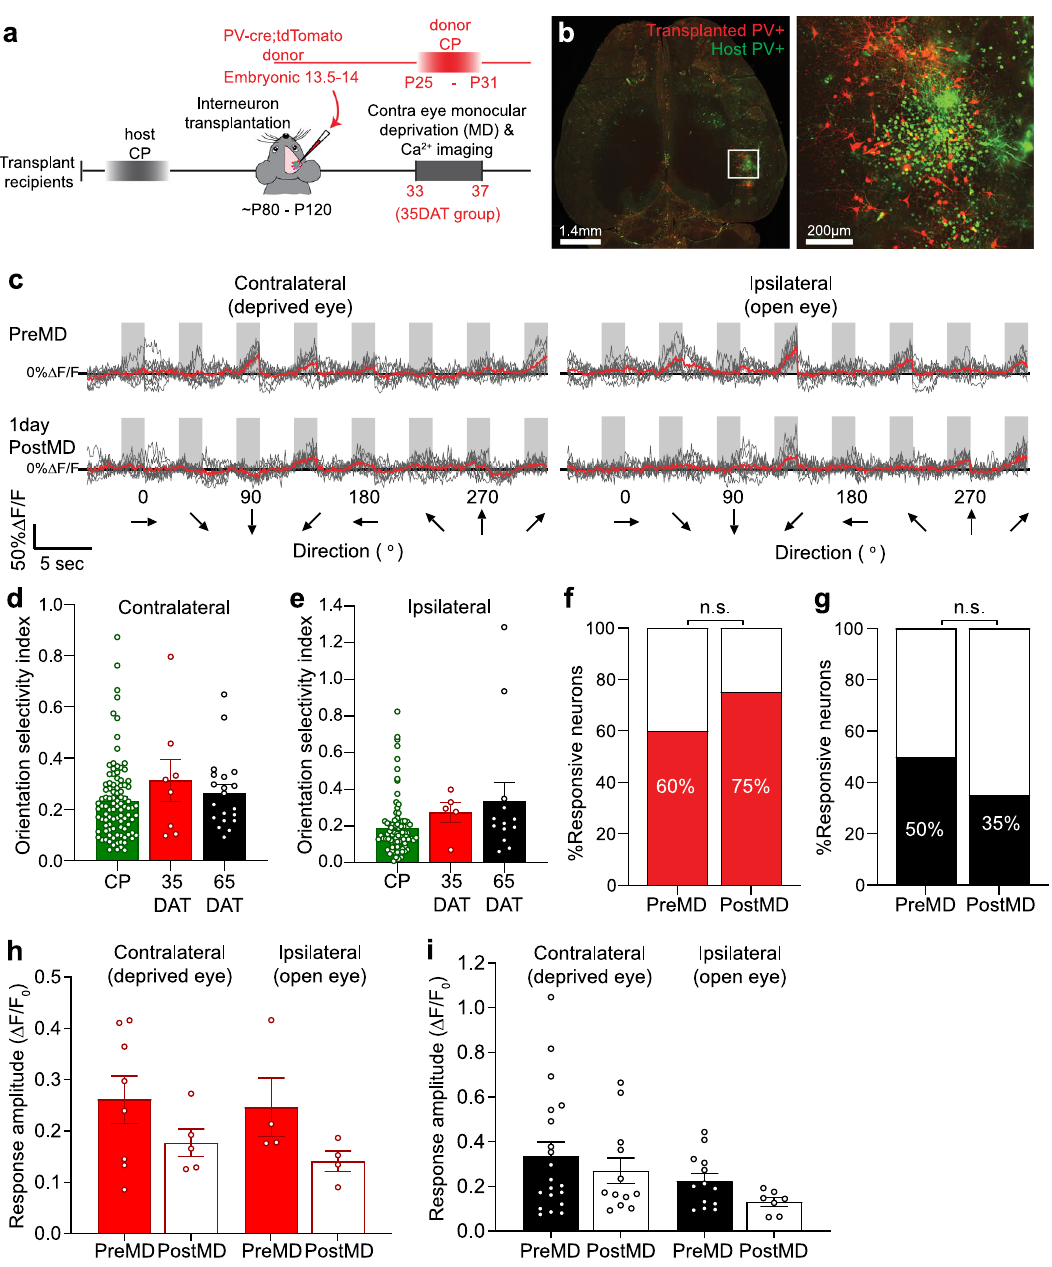
Fig. 3 Transplanted PV interneurons are not sensitive to MD. a Experimental timeline. The calcium imaging of transplanted PV interneurons was performed at 33 – 35 days after transplant (35DAT) or 65 – 70DAT. b Left: whole brain image of transplant recipient cleared using iDISCO + method, scale bar = 1.4mm. Right: a magni fi ed view of the outlined region in the left panel. Transplanted PV interneurons are in red, and AAV1-GCaMP6s-labeled host PV interneurons are in green and transplanted PV interneurons are in yellow, scale bar = 200 µ m. This experiment was performed in one transplant recipient. c Visually evoked responses of an example transplanted PV interneuron. d , e There was no difference in the orientation selectivity index between critical period (CP, green) PV interneurons, and 35DAT (red) and 65DAT (black) transplanted PV interneurons. d Orientation selectivity index for the contralateral responses (CP: n = 98 cells from 3 mice; 35DAT: n = 8 cells from 6 mice; 65DAT: n = 20 cells from 5 mice; p = 0.339, Kruskal – Wallis ANOVA test). e Orientation selectivity index for the ipsilateral responses (CP: n = 84 cells from 3 mice; 35DAT: n = 5 cells from 5 mice; 65DAT: n = 13 cells from 5 mice; CP vs. 35DAT, p = 0.144; 65DAT vs. 35DAT, p = 0.999 Kruskal – Wallis ANOVA with Dunn ’ s multiple comparison test). f Responsiveness of transplanted PV interneurons at 35DAT remained unchanged after 1D MD (PreMD: n = 15 cells from 6 mice; PostMD: n = 8 cells from 3 mice, p = 0.657, Fisher ’ s exact test). g The percentage of responsive transplanted PV interneurons also remained unchanged after MD for the 65DAT group (PreMD: n = 50 cells from 5 mice; PostMD: n = 37 cells, p = 0.194, Fisher ’ s exact test). h The response amplitude of transplanted PV interneurons did not change after 1D MD for either the contralateral or ipsilateral eye (Contra PreMD: n = 8 cells from 6 mice, solid red; PostMD: n = 5 cells from 4 mice, open red; p = 0.284, Mann – Whitney U -test, two-tailed; Ipsi PreMD and PostMD: n = 4 cells from 4 mice; p = 0.114, Mann – Whitney U -test, two-tailed). i MD also did not signi fi cantly alter the response amplitude of transplanted PV interneurons at 65DAT through the contralateral eye (PreMD: n = 20 cells from 5 mice, solid black; PostMD: n = 12 cells from 5 mice, open black; p = 0.604, Mann – Whitney test, two-tailed) or ipsilateral eye stimulation (PreMD: n = 13 cells from 5 mice, solid black; PostMD: n = 7 cells from 2 mice, open black; p = 0.114, Mann – Whitney test, two-tailed). Data in d , e , h , and i are represented as mean ± SEM.